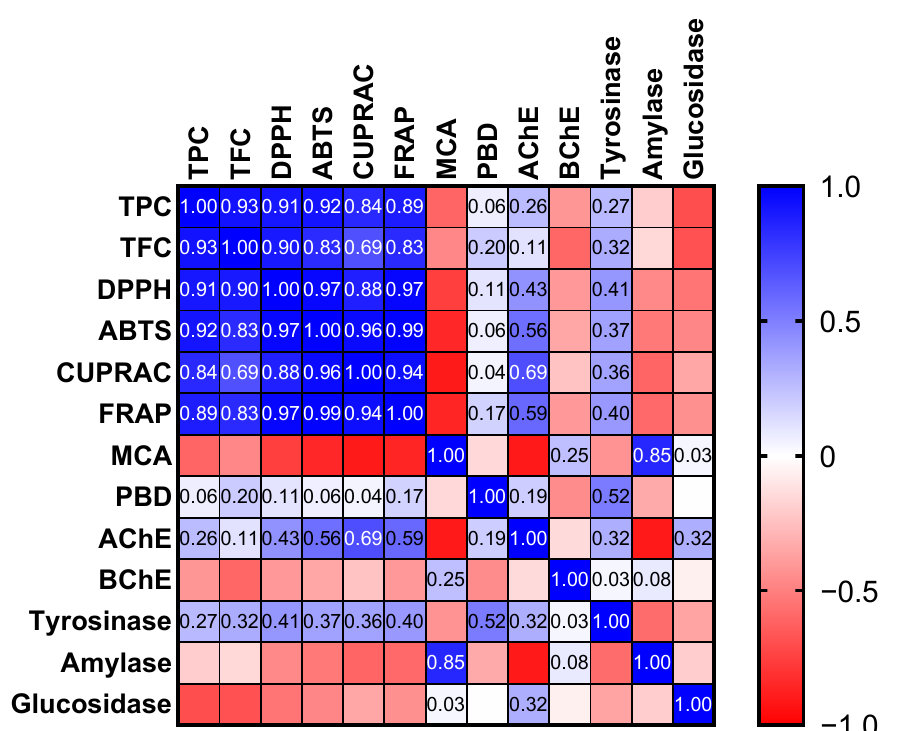
Figure 3. Pearson correlation values between biological activity assays ( p < 0.05). TPC: Total phenolic content; TFC: Total flavonoid content; ABTS: 2,2 (cid:48) -azino-bis(3-ethylbenzothiazoline-6-sulphonic acid; DPPH: 1,1-diphenyl-2-picrylhydrazyl; CUPRAC: Cupric reducing antioxidant capacity; FRAP: Ferric reducing antioxidant power; MCA: Metal chelating ability; PBD: Phosphomolybdenum; AChE: acetylcholinesterase; BChE: